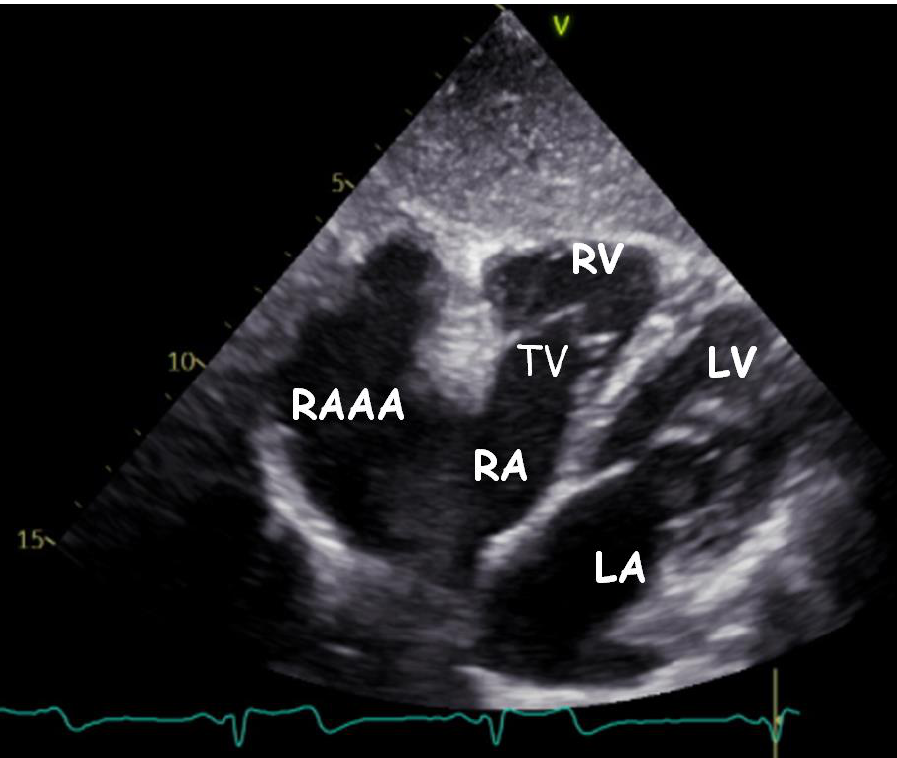
Figure 5. Transthoracic echocardiogram. Modified subcostal view showing the gigantic RAAA ten years later.